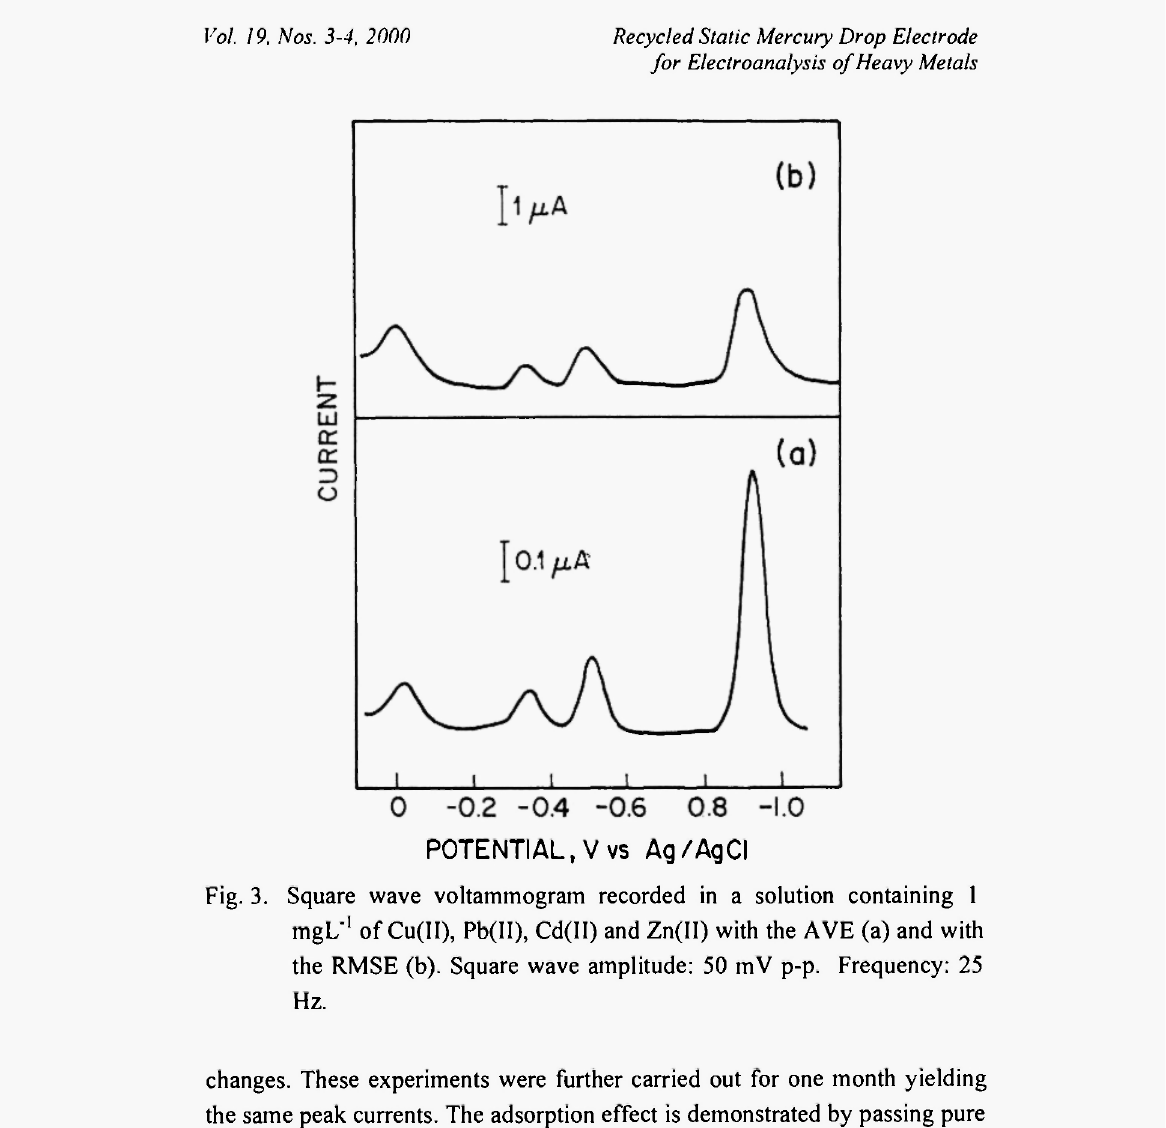
Fig. 3. Square wave voltammogram recorded in a solution containing 1 mgL" 1 of Cu(II), Pb(II), Cd(II) and Zn(II) with the AVE (a) and with the RMSE (b). Square wave amplitude: 50 mV p-p. Frequency: 25